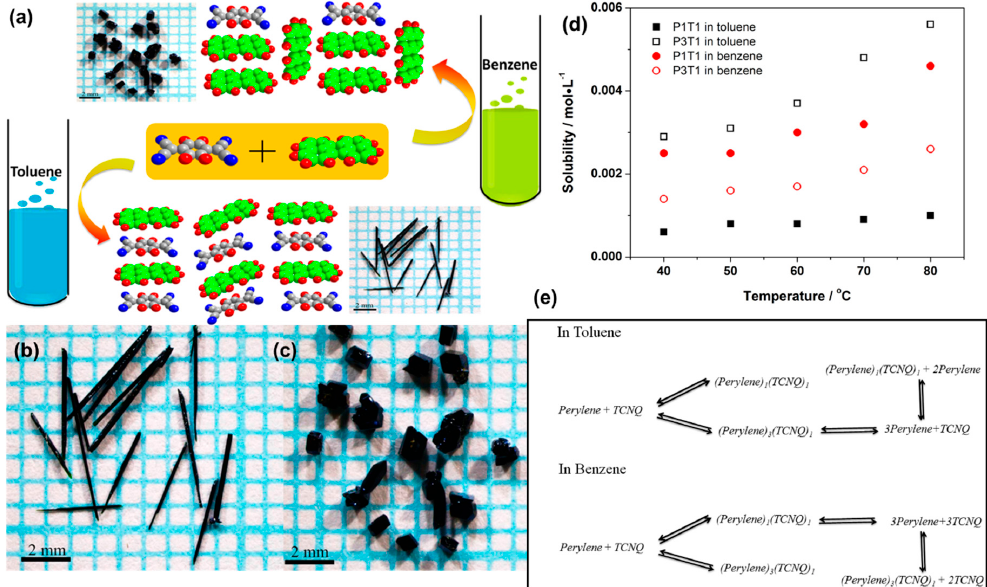
Figure 4. ( a ) Single-crystals growth of (perylene) 1 -(TCNQ) 1 and (perylene) 3 -(TCNQ) 1 by slow cooling method exhibits a solvent-dependent on the stoichiometry; ( b ) Optical images of (perylene) 1 -(TCNQ) 1 single crystals from toluene; ( c ) Optical images of (perylene) 3 -(TCNQ) 1 single crystals from benzene; ( d ) The solubilities of (perylene) 3 -(TCNQ) 1 and (perylene) 1 -(TCNQ) 1 in toluene and benzene at different temperatures (mol/L); ( e ) All possible equilibria in the perylene-TCNQ system. TCNQ: tetracyanoquinodimethane. Data are reproduced with permission from [59].